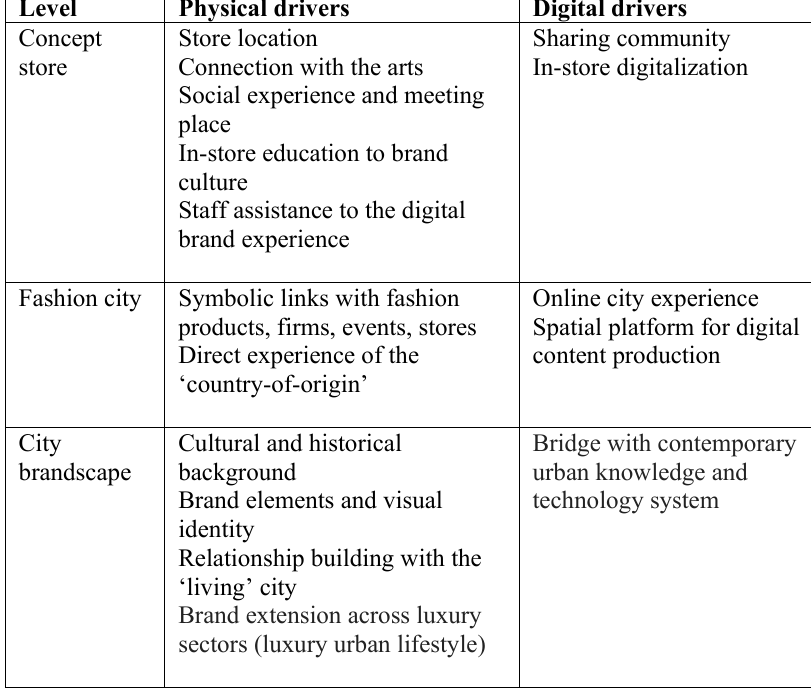
Table 2: The Concept Store Experience: Summary of Key Drivers